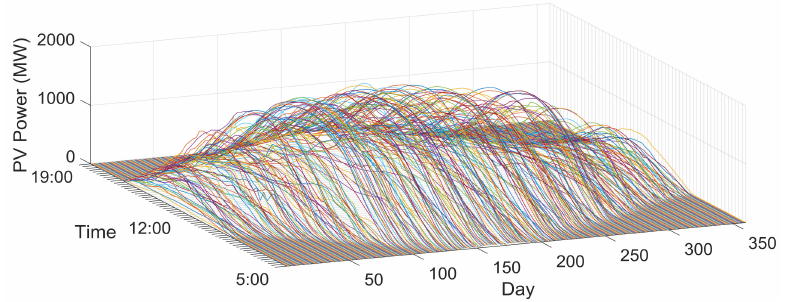
Figure 6. The PV power curves in Flanders, Belgium.